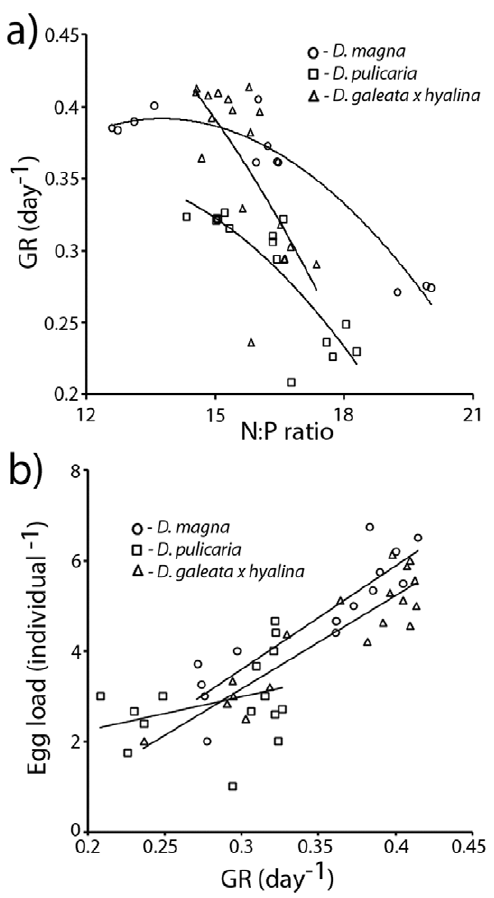
Figure 2. Relationships between A) specific growth rates and N:P ratios, and B) specific growth rate and clutch size for Daphniamagna (circles), D.pulicaria (squares) and D.galeatax hyalina (triangles). Lines were fitted using